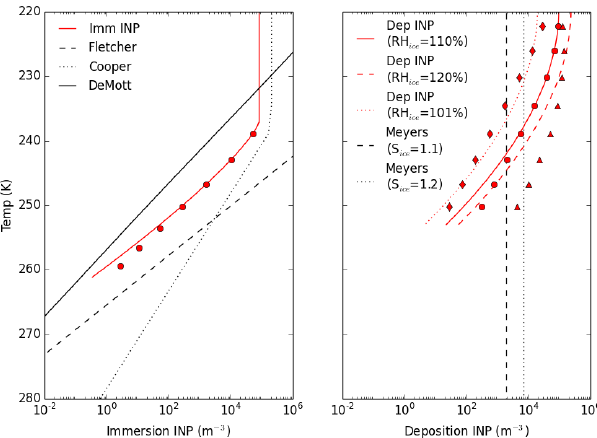
Figure 3. Left: immersion INP concentrations from Eq. (1) us- ing yearly parameters (red). The red circles represent the model data. The black dashed line is the Fletcher (1962) parameterisa- tion, the dotted line represents the Cooper (1986) parameterisation, and the solid line represents DeMott et al. (2014) parameterisation. Right: deposition INP from Eq. (3) using yearly parameters (red), at RH ice = 110% (solid), RH ice = 120% (dashed) and RH ice = 101% (dotted). The black vertical dashed (dotted) line represents concentrations from Meyers et al. (1992) at S ice = 1.1 ( S ice = 1.2). The red circles (diamonds/triangles) represent the model data at RH ice = 110% (RH ice = 101% /